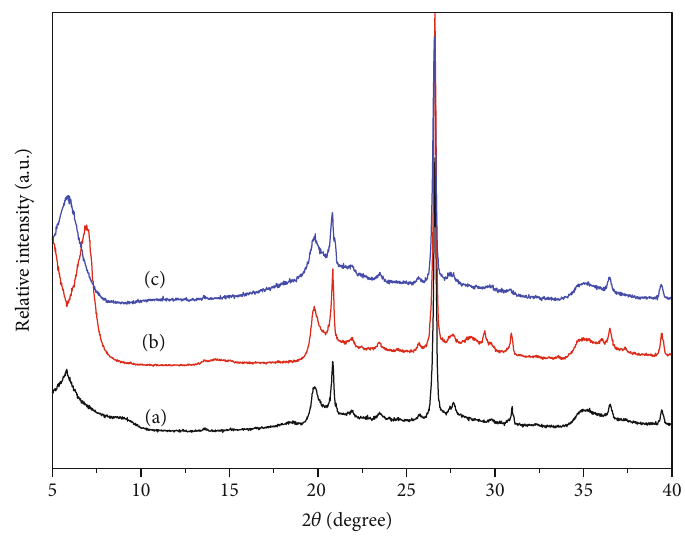
Figure 2: X-ray di ff usion spectra of bentonite (a), AlBT (b), and CSBT